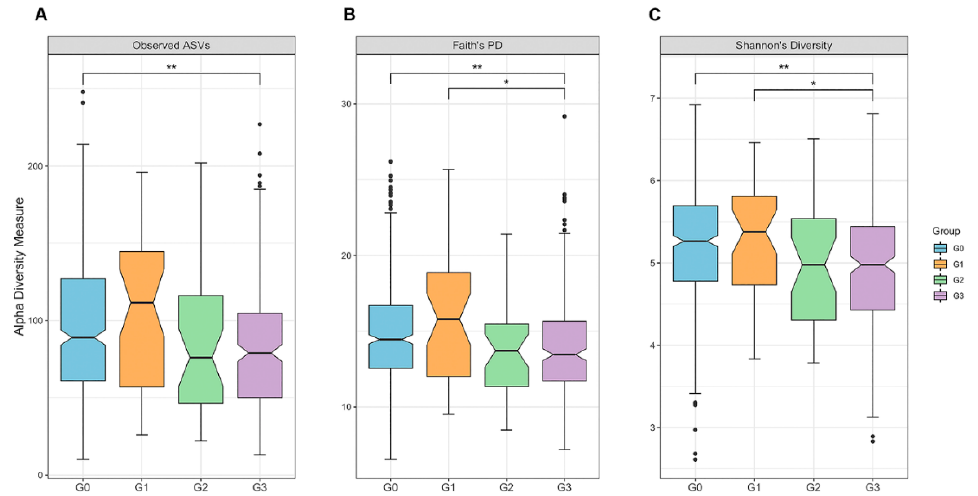
Figure 2. Alpha diversity among groups: ( A ) observed features ( p = 1.9 × 10 − 3 for all groups, Kruskal–Wallis test), ( B ) phylogenetic diversity (Faith’s PD, p = 2.7 × 10 − 4 for all groups), ( C ) Shannon index ( p = 3.2 × 10 − 5 for all group). * q < 0.05, ** q < 0.01 (pairwise Kruskal–Wallis test,